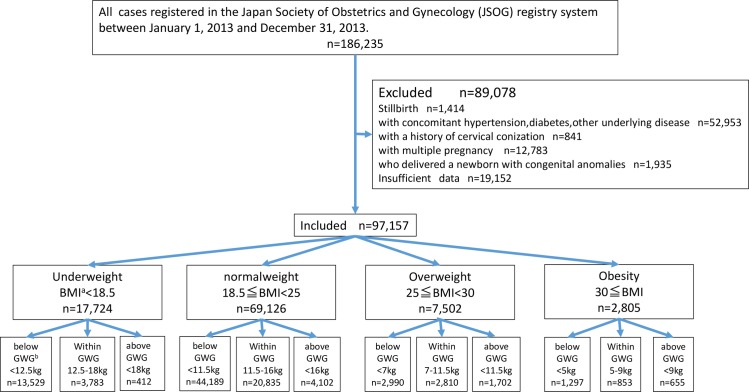
Flow diagram of study inclusion.aBMI, body mass index; bGWG, gestational weight gain.